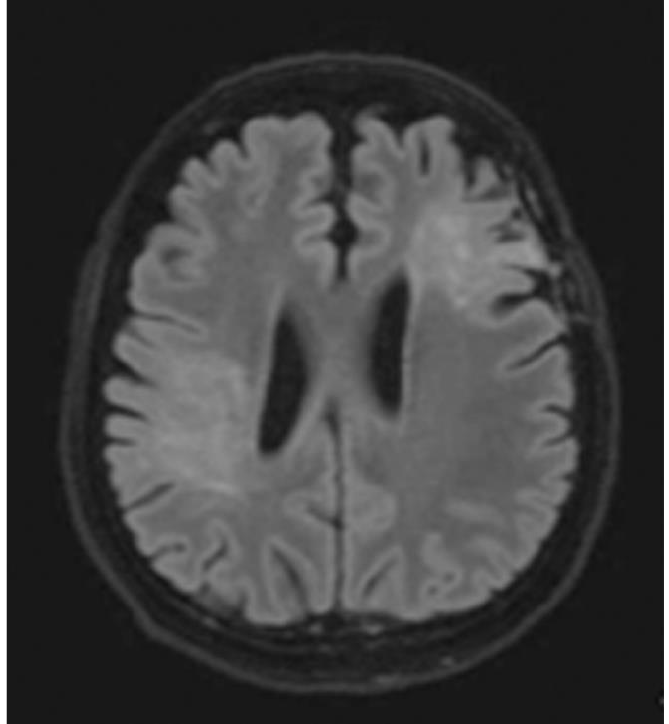
Figure 3. A follow-up axial post-contrast FLAIR image of the same patient performed one year after the diagnosis, showing marked improvement in lesions.